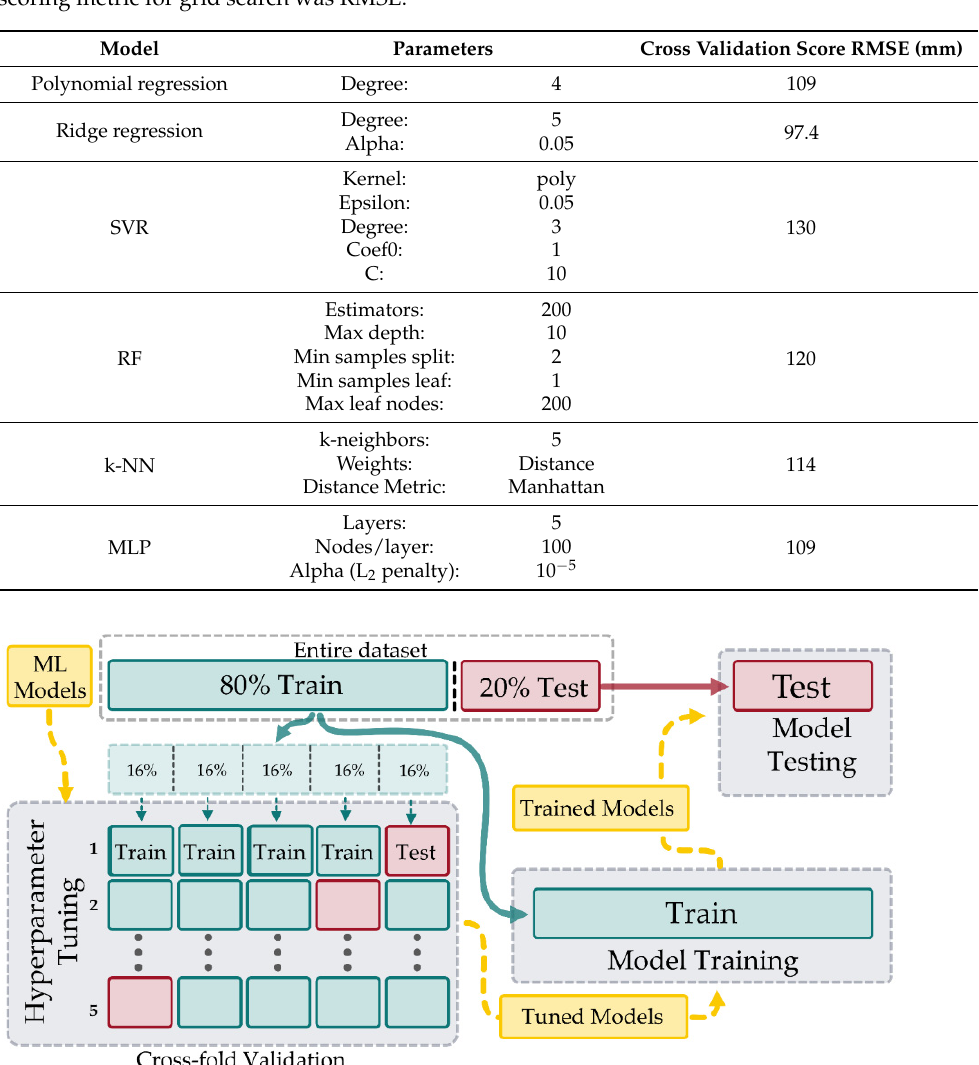
Figure 18. The data set is initially split into 80% training and 20% testing. The ML hyperparameters are then tuned using 5-fold cross-validation of the 80% training data by splitting into 5 folds and iterating 5 times through the folds, each time selecting 4 folds for training and the remaining for validation. The resulting five scores are then averaged to compute the score for a set of hyperparameters. Once tuned, the ML models are retrained using all of the 80% training data and assessed for final performance on the 20% test set. Table 3. Results of the hyperparameter tuning. The listed parameters for each of the models were tuned using two rounds, the first being successive powers of 10, the second being powers of 2. The scoring metric for grid search was RMSE. 109 Table 4. Accuracy of the ML in mm after being retrained on the entire 80% training set and tested on the 20% test set. Model